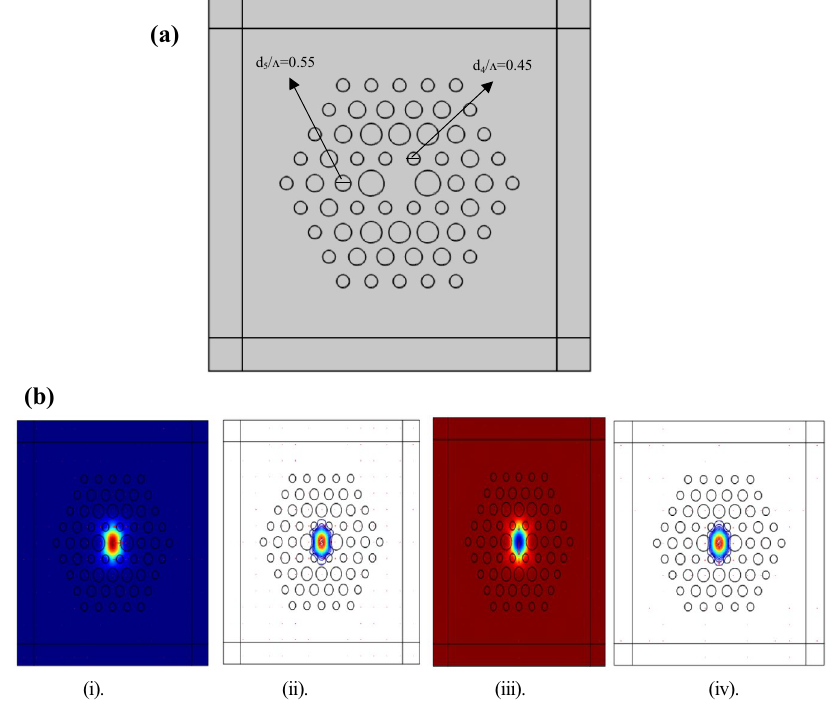
Fig. 2 a Cross-section of the PCF2 structure. b The fundamental mode profiles at 1.55 µm for X -polarisation (i, ii). Y -polarisation (iii, iv)